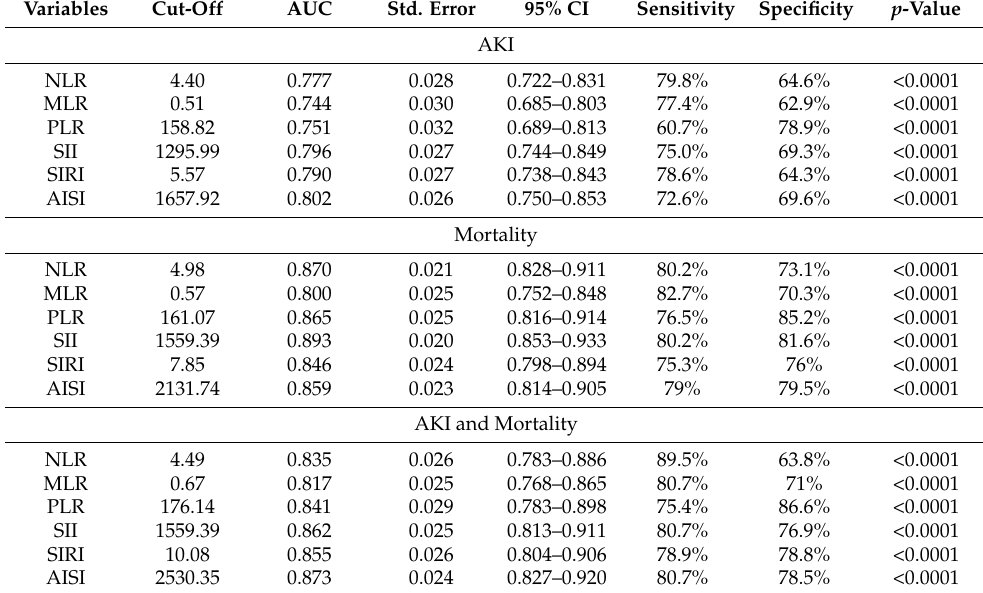
Figure 3. ROC curve analysis concerning the composite endpoint ( A ) NLR (AUC: 0.835; p < 0.0001), inflammatory ( B ) MLR (AUC: 0.817; p < 0.0001), ( C ) PLR (AUC: 0.841; p < 0.0001), ( D ) SII (AUC: 0.862; p < 0.0001),